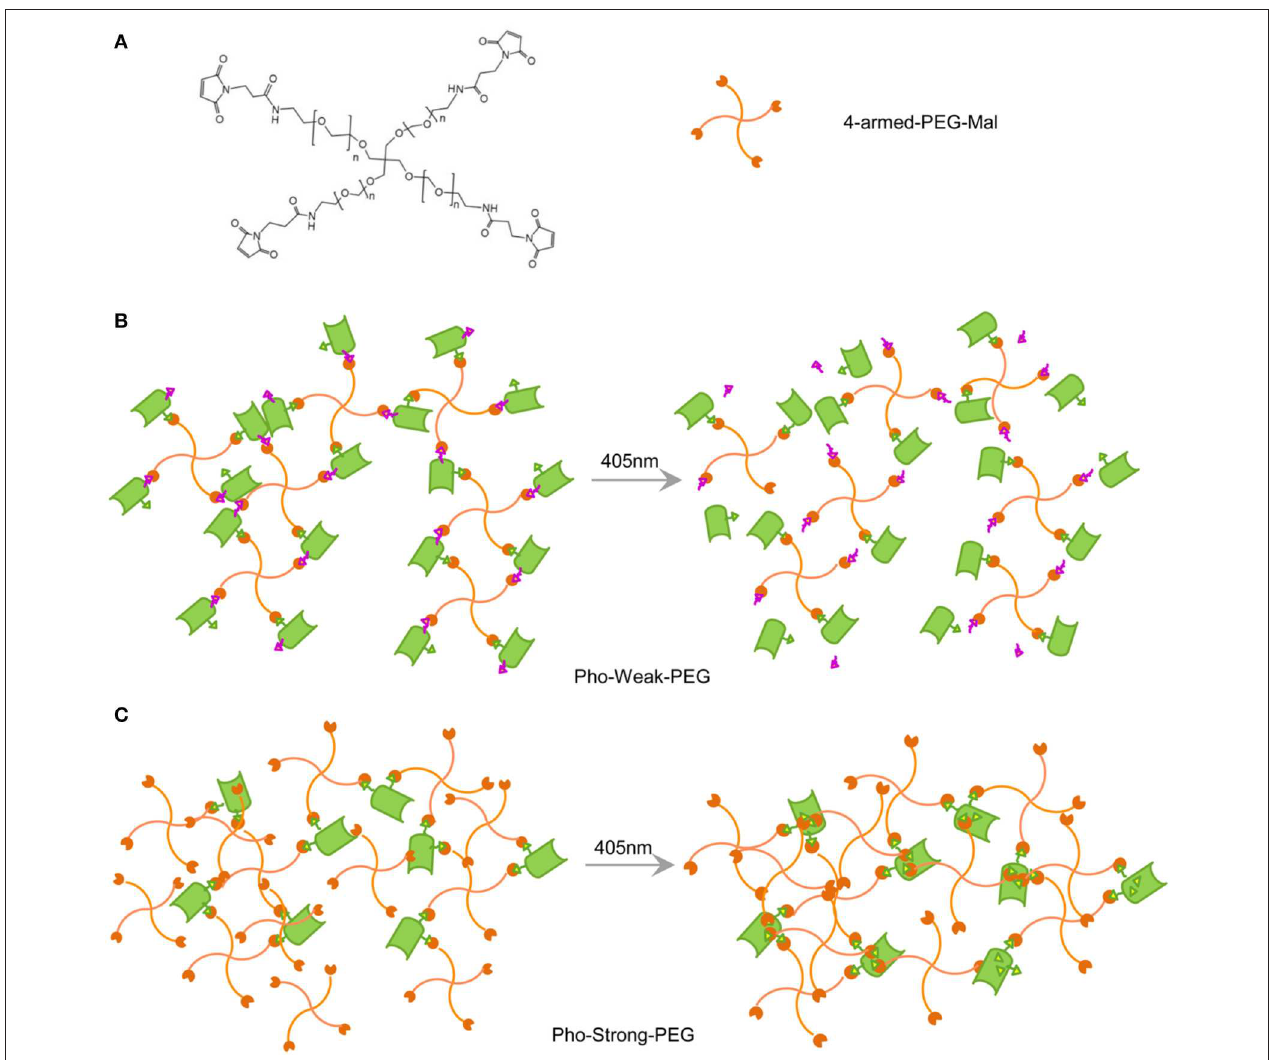
FIGURE 2 | Design of PhoCl-PEG hydrogels. (A) Chemical structure of 4-armed-PEG-Mal. The maleimide-terminated end of each arm can react with thiol groups of cysteines when they are solvent exposed. (B) Schematic illustration of the Pho-Strong-PEG hydrogel in dark (left) and the photo-switching process of the hydrogel (right). (C) Schematic illustration of the Pho-Weak-PEG hydrogel in dark (left) and the photo-switching process of the hydrogel